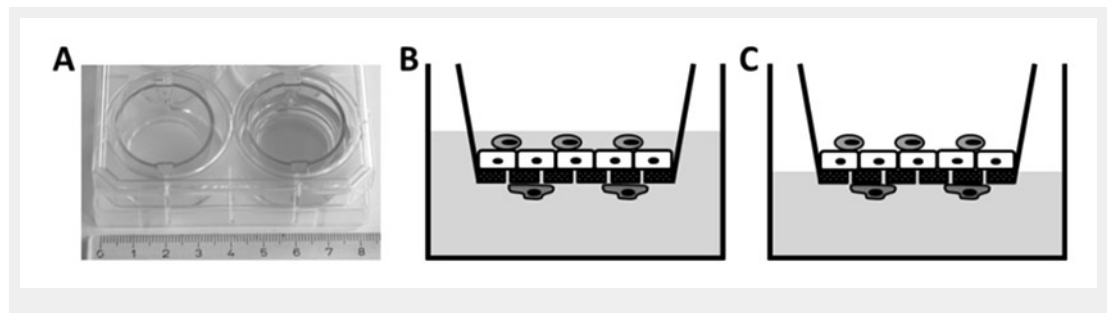
Figure 5 Two chamber cell culture system. A conventional two chamber cell culture system in a six-well culture dish. Cells are grown on a porous polyethylene terephthalate (PET) membrane. For better visualisation, the well on the left does not contain medium. B/C Triple cell co-culture model of the human air-liquid barrier consisting of macrophages (light gray, top), epithelial cells (white, middle) and dendritic cells (dark grey, bottom). The cells can be kept submerged (B) or at the air-liquid interface